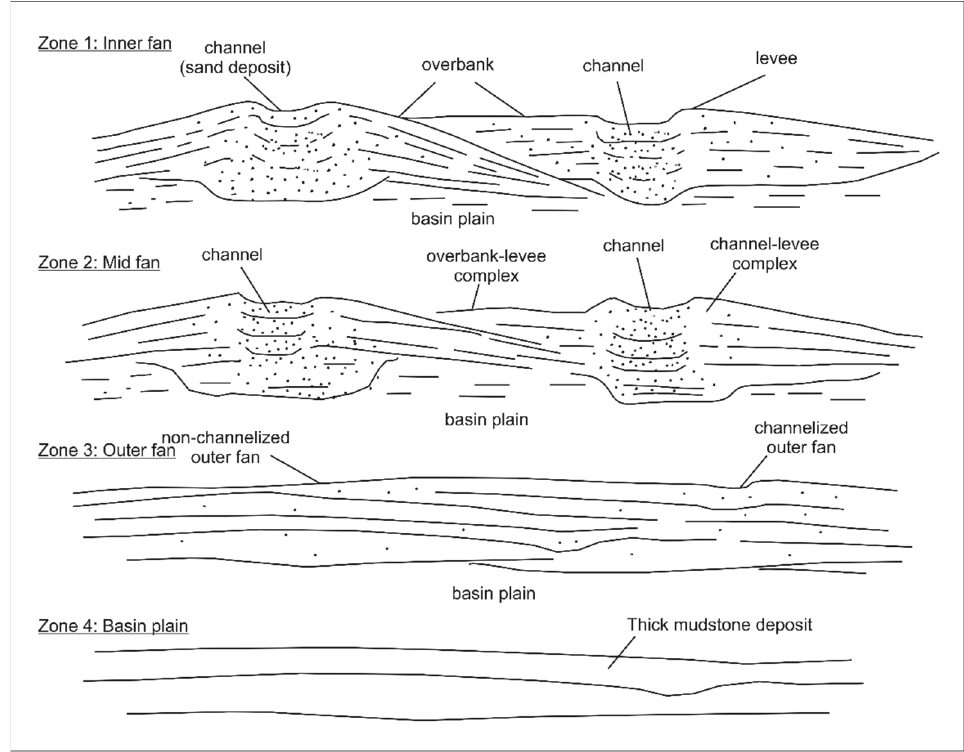
Figure 9. Summary of a depositional model for the northern part of the Crocker Formation. The schematic drawing shows a complete proximal turbidite fan to the basin plain of the deep-water depositional environment in a lateral view.